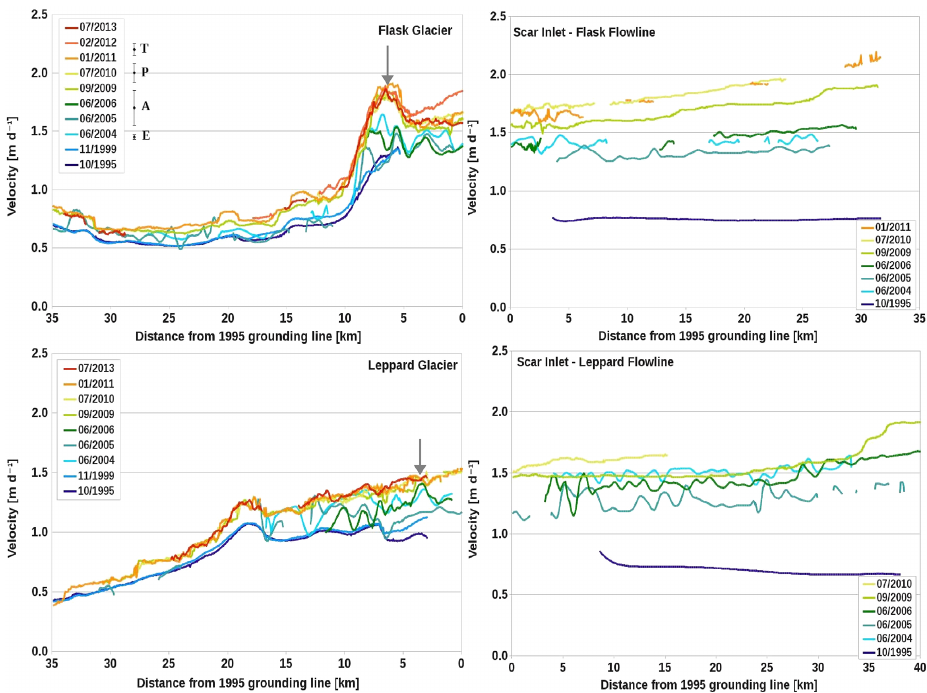
Figure 6. Surface velocities along the central flow line of Flask (top left) and Leppard (bottom left) glaciers and downstream of these glaciers on Scar Inlet ice shelf (right, top and bottom). Different y scale for the Leppard flow line. The arrow shows the location of the flux gate. Position of flow-line profiles shown in Fig.1 and of flux gates in Fig. 5. The vertical bars show uncertainties in velocity for TerraSAR-X